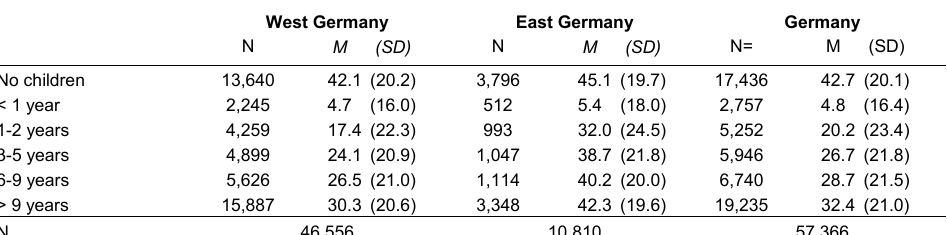
Table A3 : Descriptives of woman’s share of working hours, by presence and age of the youngest child in the household and